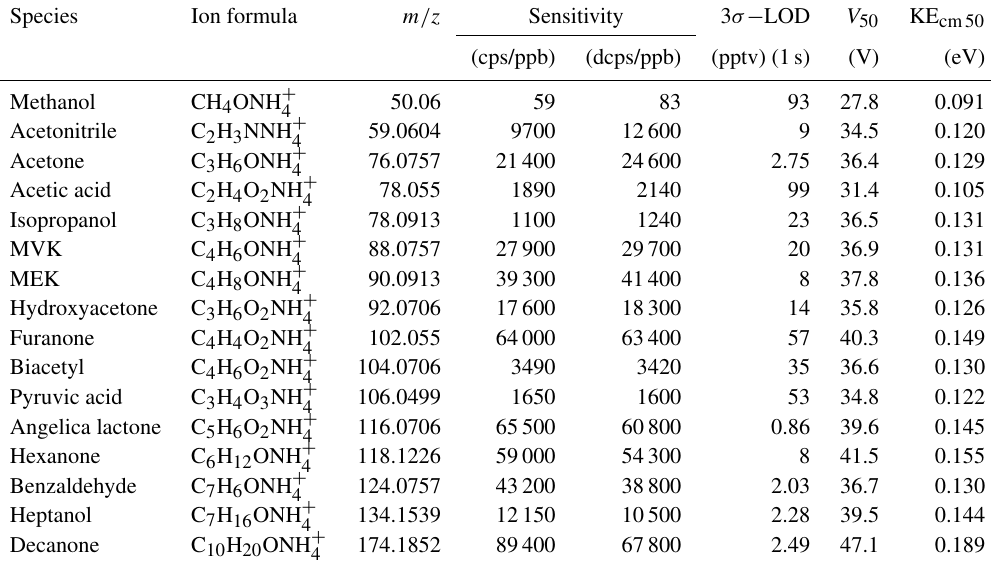
Table 1. Sensitivities and detection limits of NH + at which half of the ions have dissociated.